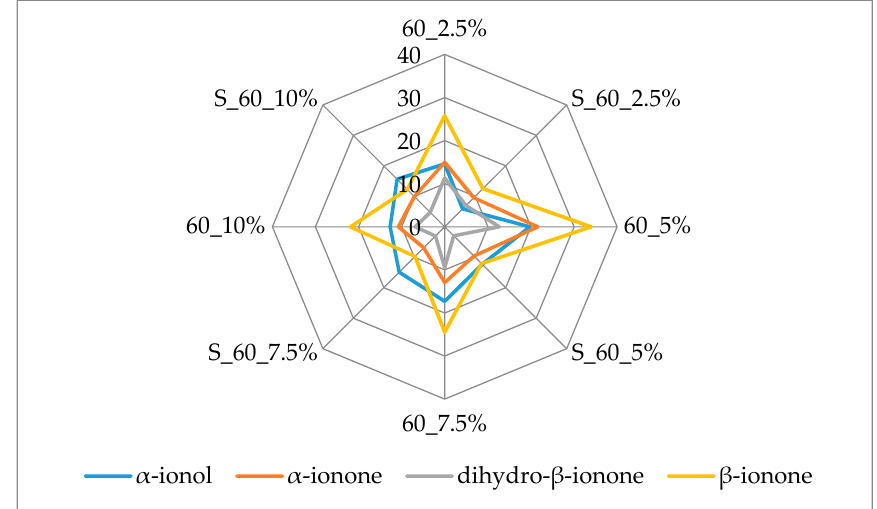
Figure 4. Amount of berry volatiles on cellulose/raspberry complexes after 60 min of complexation and after storage (2.5%, 5%, 7.5% and 10%—amounts of used cellulose; 60—time of complexation; S—storage).